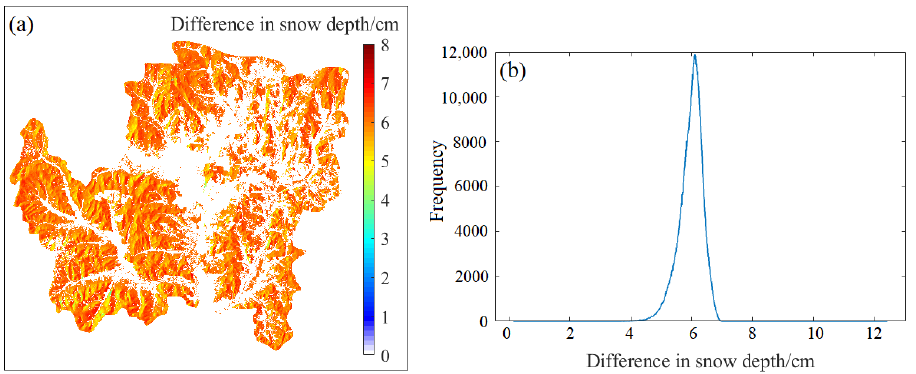
Figure 14. Comparative analysis of snow depth before and after the introduction of forest phase: ( a ) snow depth difference map; ( b ) histogram of snow depth difference frequency distribution.